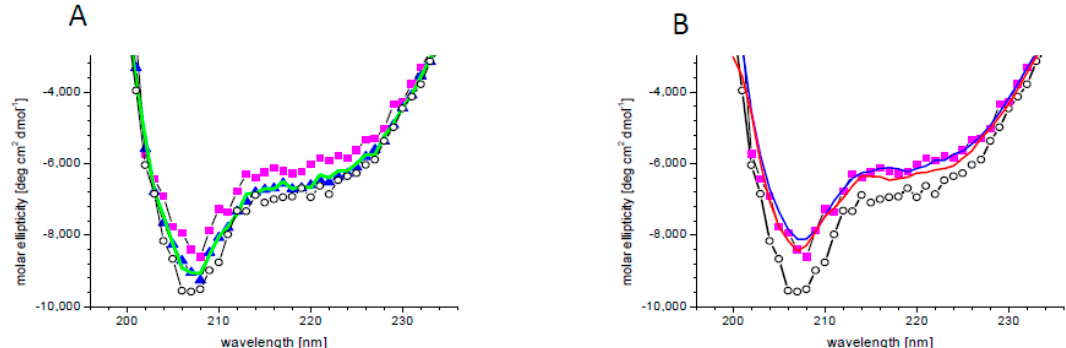
Figure 2. Changes in SnRK2.4 conformation upon PA binding. ( A ) Circular dichroism (CD) spectra of SnRK2.4 kinase without lipids (open circles) and with 5 µ M lipid solution of PA 16:0 / 18:1 (magenta squares), PA 18:1 (blue triangles), and PC (green line). ( B ) CD spectra of SnRK2.4 kinase without lipids (open circles) and in the presence of PA 16:0 / 18:1 at 5 (magenta squares), 10 (blue line), and 50 (red line) µ M.